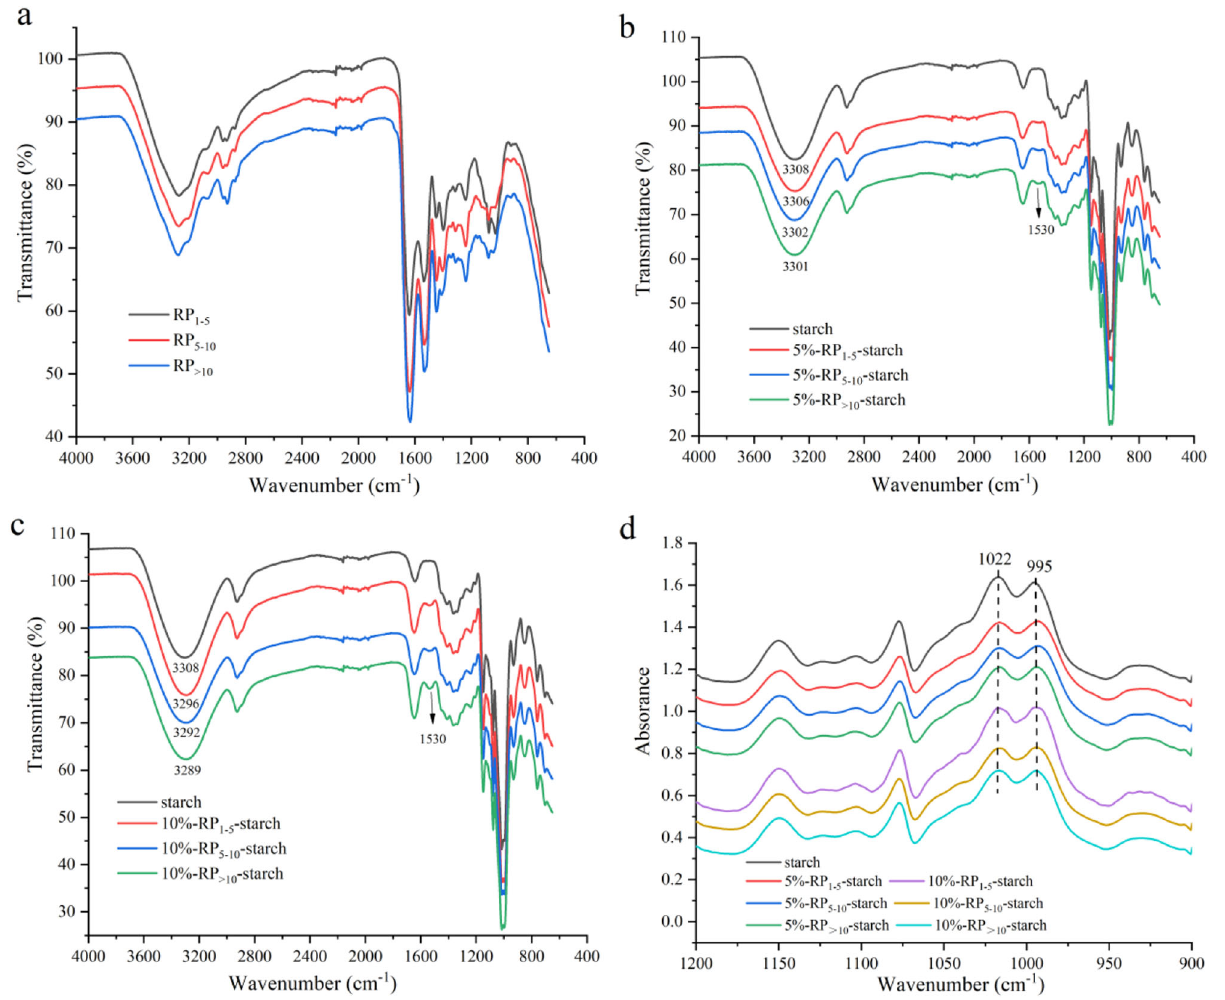
Fig. 3 FTIR and deconvoluted FTIR spectra of cooked starch and RP-starch complexes. a FTIR spectra of rice peptides with different molecular weights (1 – 5, 5 – 10, and >10 kDa). b FTIR spectra of 5% RP-starch complexes. c FTIR spectra of 10% RP-starch complexes. d Deconvoluted FTIR spectra of 5% RP-starch complexes and 10% RP-starch